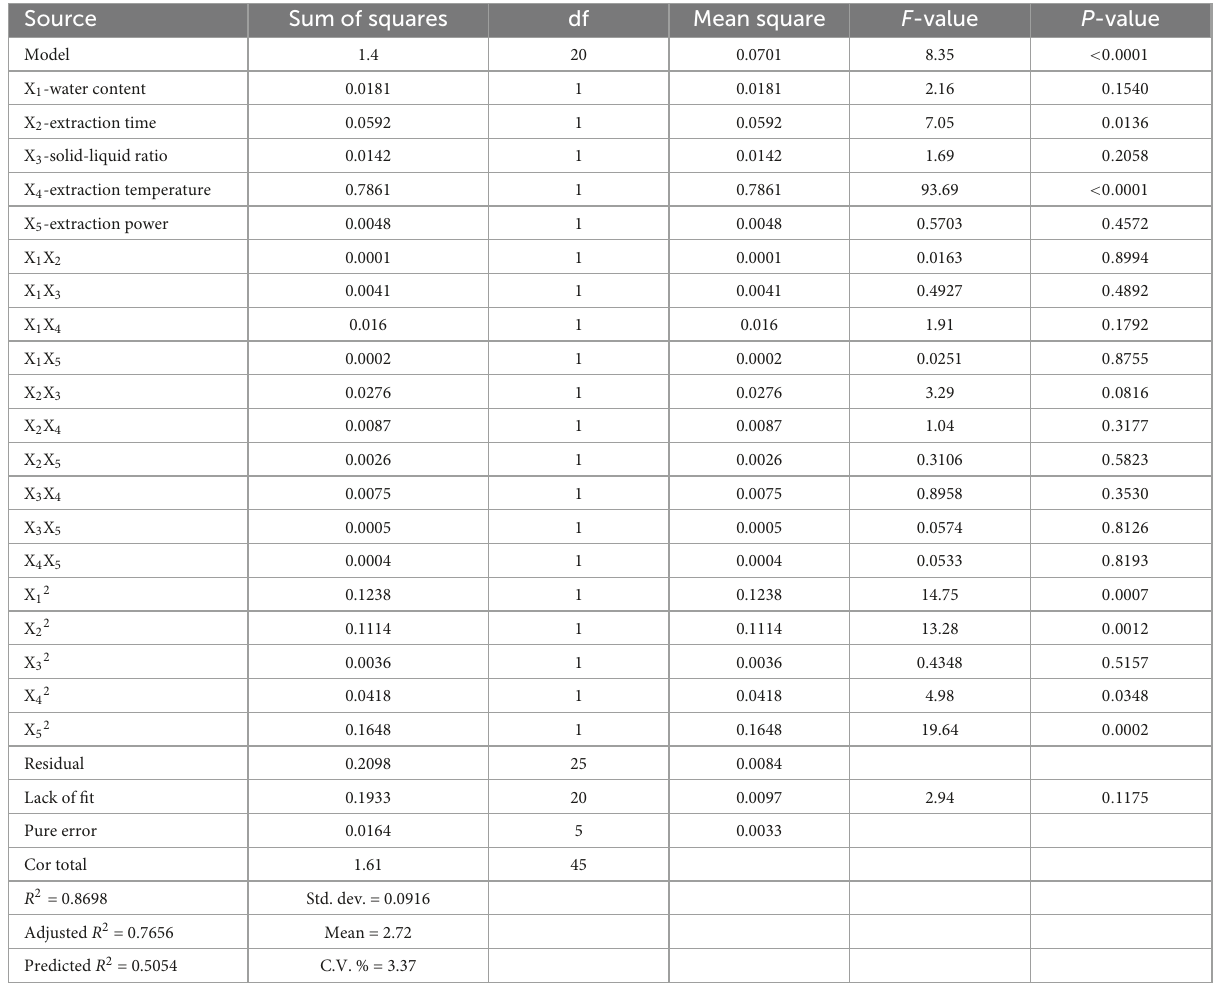
TABLE 5 Analysis of the variance (ANOVA) for the second-order polynomial model.